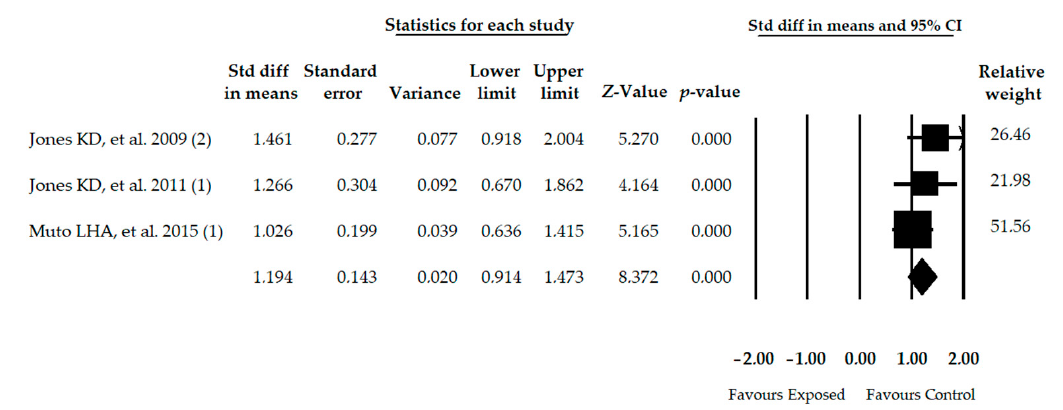
Figure 3. Forest plot of the meta-analysis of balance confidence. Std diff, Standardized difference; CI, Confidence interval.